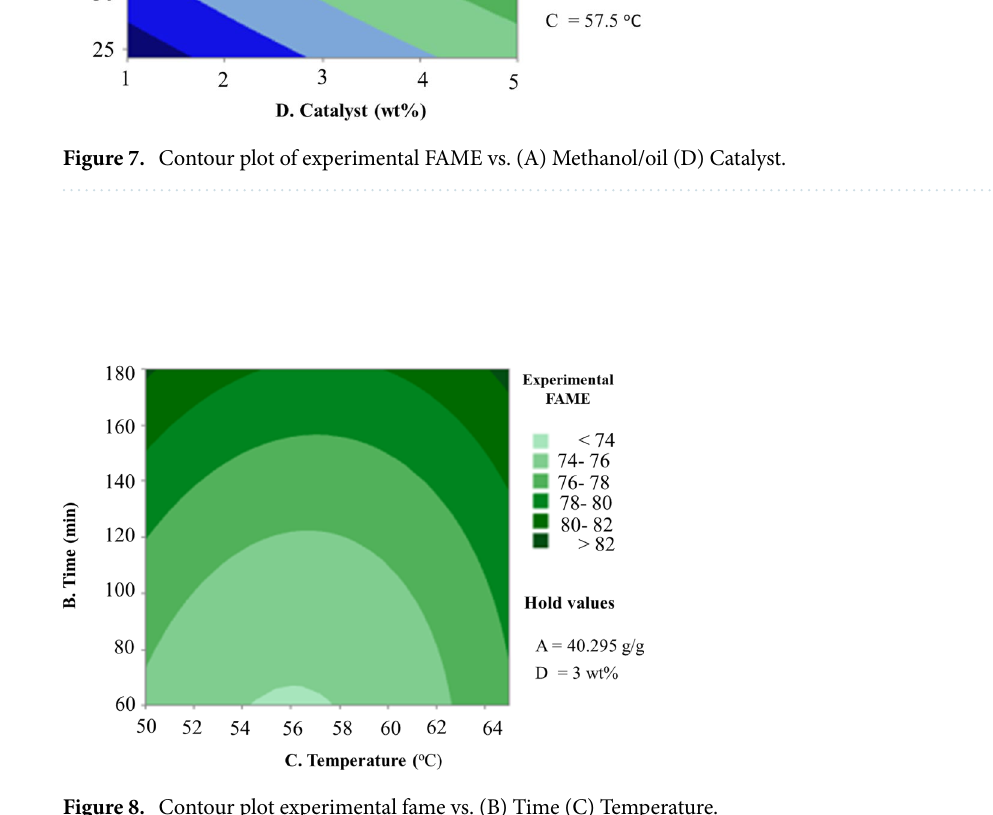
Figure 8. Contour plot experimental fame vs. (B) Time (C)